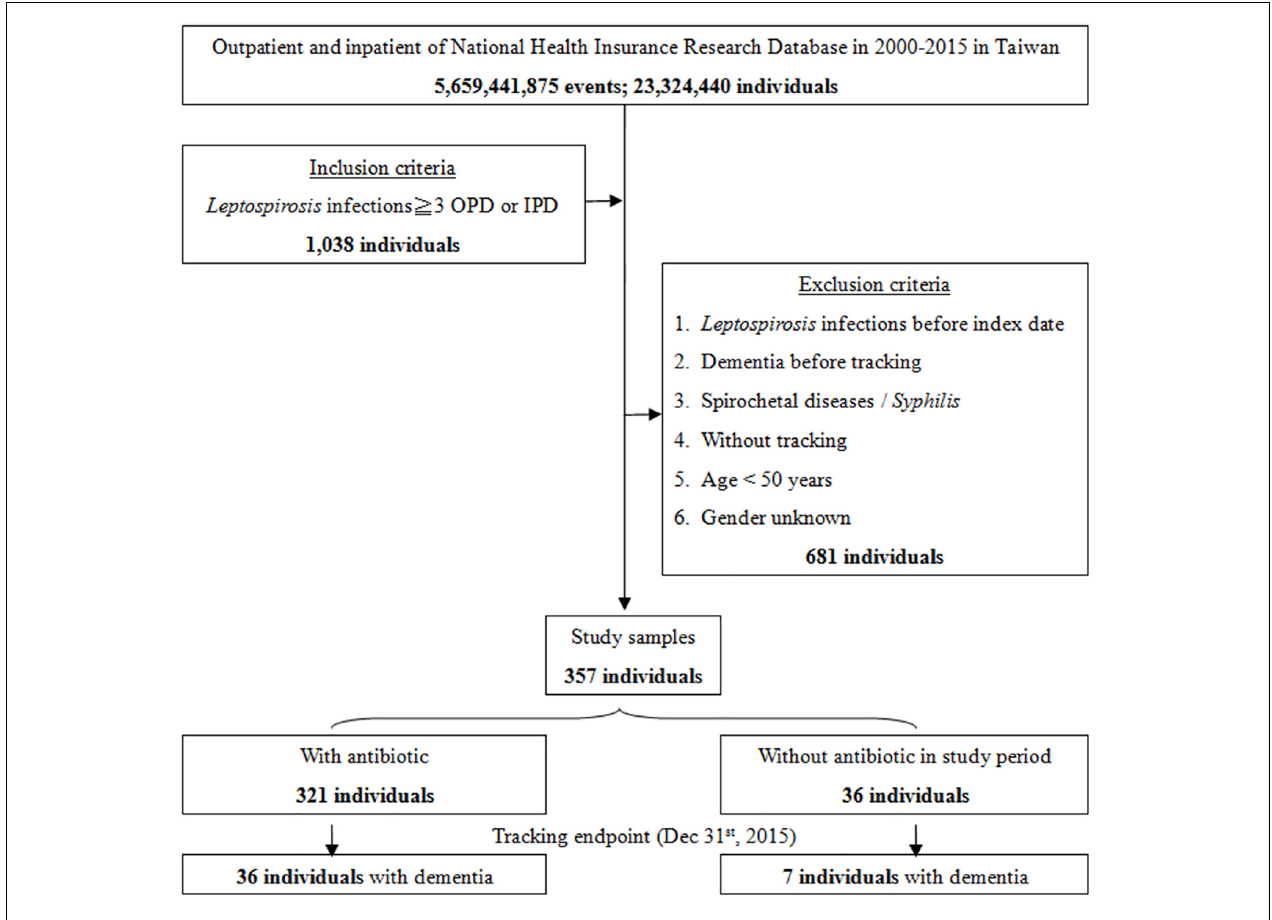
FIGURE 3 | The flowchart of study sample selection with or without antibiotic treatment.